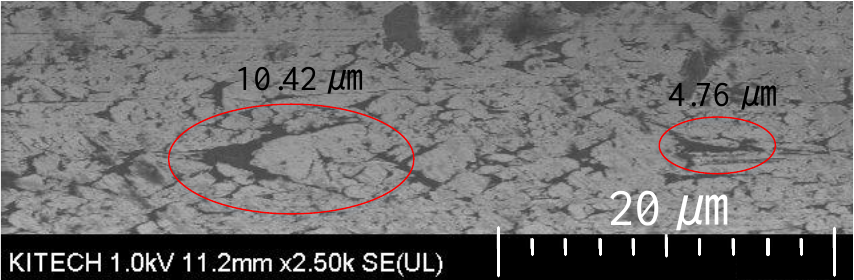
Figure 15. SEM image ( × 2500 ) of the final drawn wire.